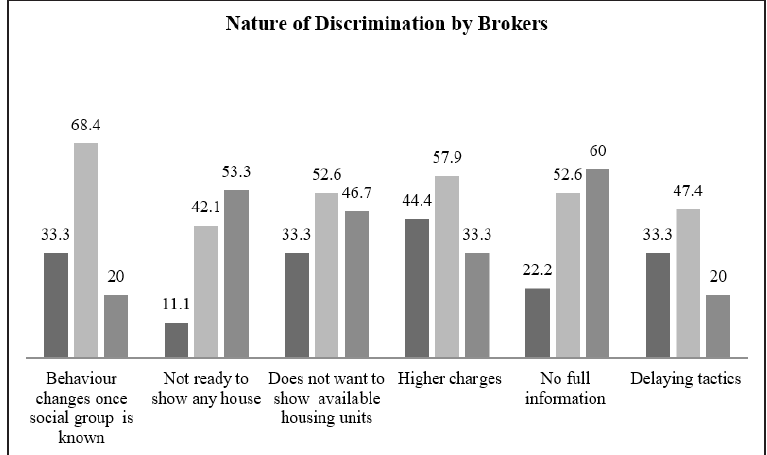
Fig 4. Nature of Discrimination by Brokers Source: Primary Field Survey